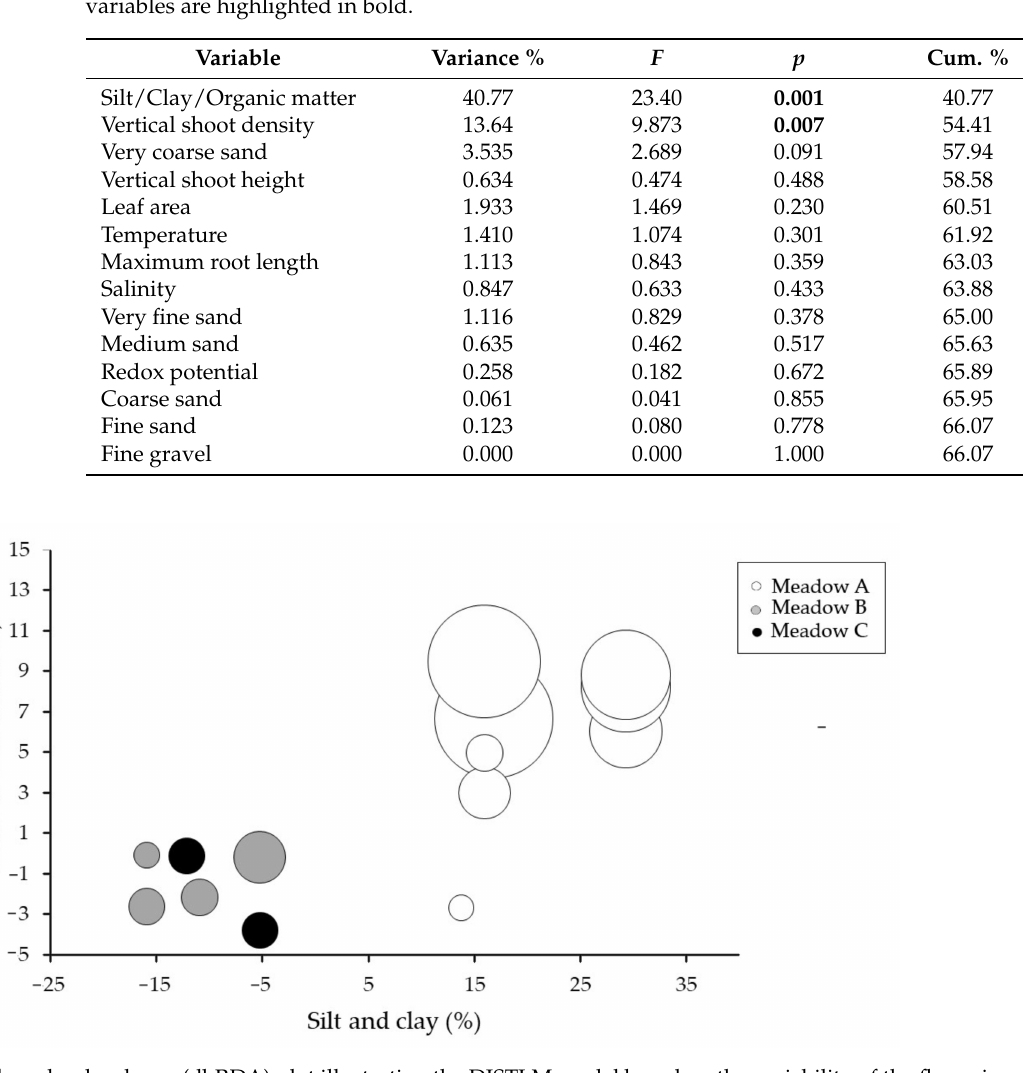
Figure 5. Distance-based redundancy (dbRDA) plot illustrating the DISTLM model based on the variability of the flowering effort over the study period considering the fitted seagrass biometrics and abiotic variables based on DISTLM analysis in Table 2. Bubble size represents the flowering effort of each seagrass meadow along the study